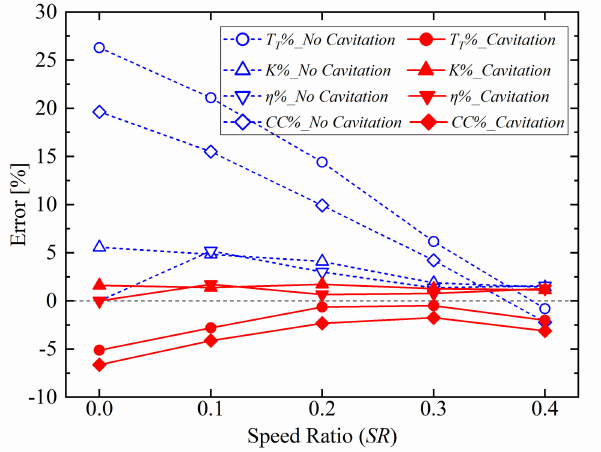
Figure 8. Error comparison of turbine torque, torque ratio, efficiency, and capacity constant between no cavitation and cavitation at various speed ratio under cavitating conditions.